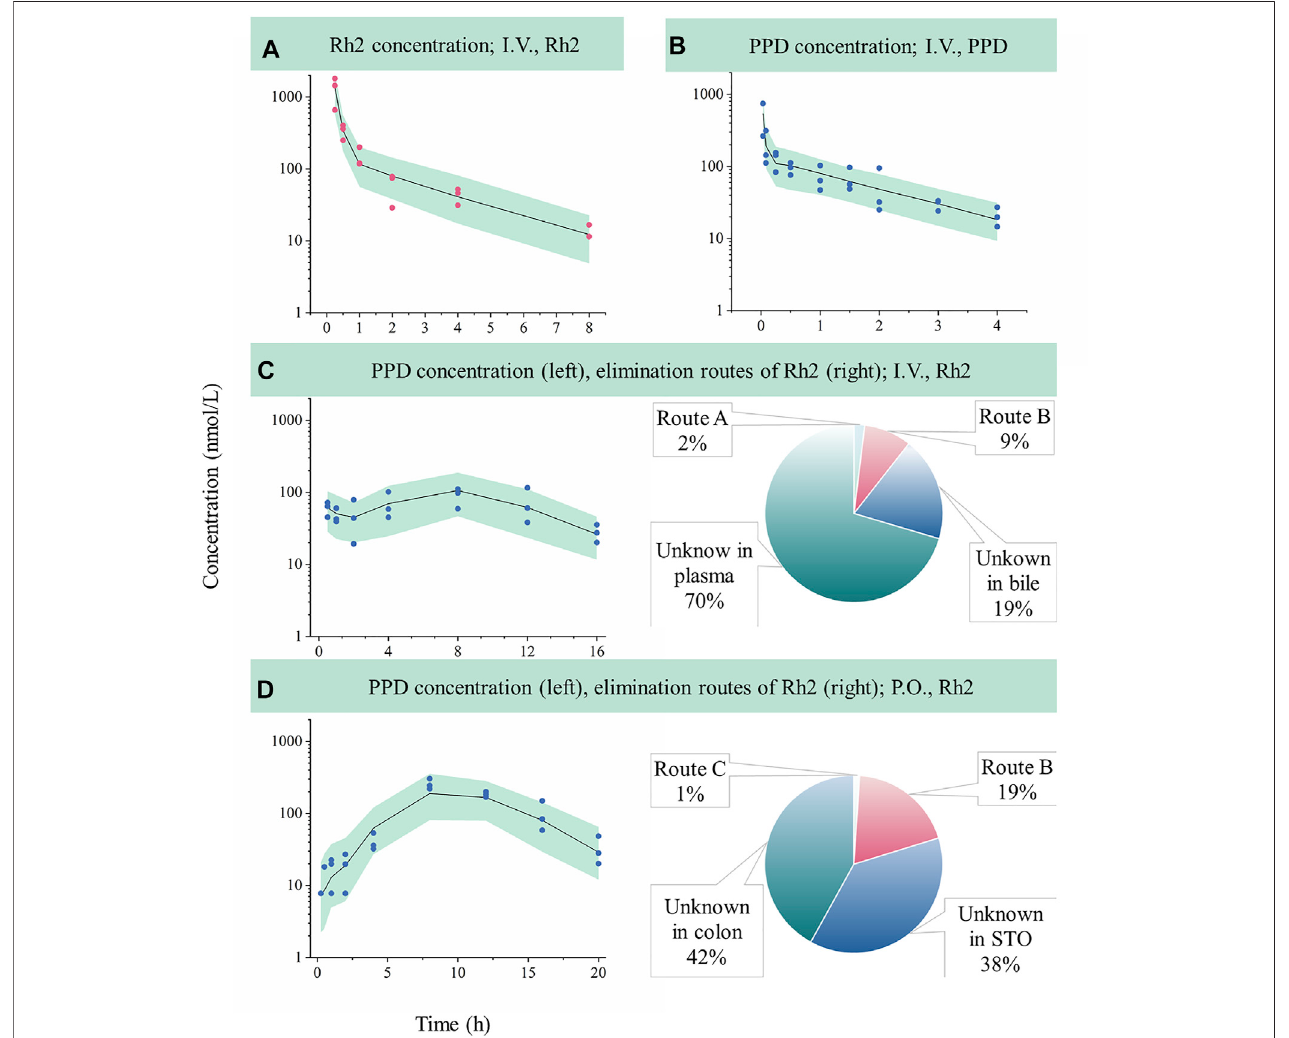
FIGURE 2 | Evaluation of model performance in rats and the calculated elimination routes of Rh2. Green areas represent the 90% con fi dence interval between the 5th and 95th of percentiles, solid lines are the median pro fi le (50th point of percentile), red symbols represent raw observations of Rh2, and blue symbols represent raw observations of PPD. (A) , Rh2 pharmacokinetic pro fi le after I.V. administration of Rh2 at 10 mg/kg; (B) , PPD pharmacokinetic pro fi le after I.V. administration of PPD at 0.2 mg/kg; (C) , PPD pharmacokinetic pro fi le after I.V. administration of Rh2 at 10 mg/kg; (D) , PPD pharmacokinetic pro fi le after P.O. administration of Rh2 at 10 mg/kg. Route A is the percentage of the administered Rh2 transformed from Rh2 to PPD in the systemic circulation; Route B is the percentage of the administered Rh2 transformedtoPPD inthecolon and absorbed intothesystemiccirculation; RouteCisthe percentage oftheadministered Rh2transformedtoPPD inthe stomach and absorbed into the systemic circulation. STO refers to